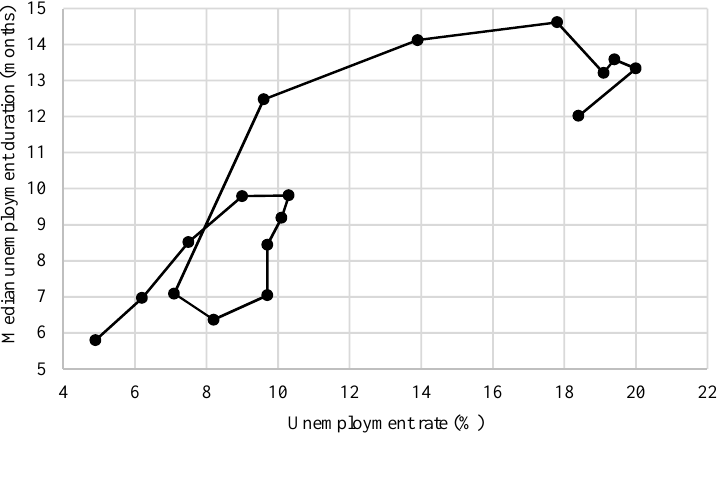
Figure 4. Relation between the unemployment rate and the median unemployment duration in Poland in years 2001–2017